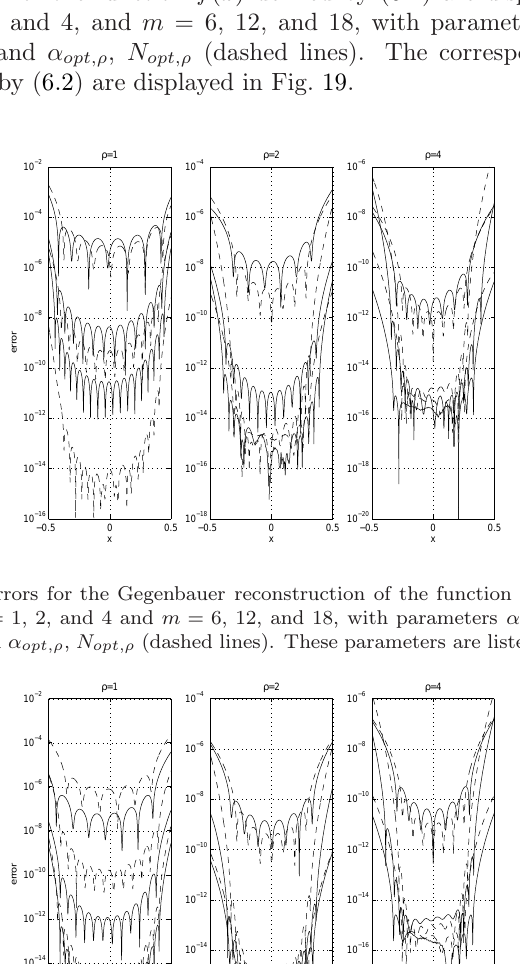
The corresponding values of N opt,ρ , N opt,I and N opt,R depend on m and are listed in Table 2 for m = 6 , 12 and 18 . The errors of the Gegenbauer reconstruction of the function f ( x ) defined by (6.1) are displayed in Fig. 18 for ρ = 1 , 2 , and 4 , and m = 6 , 12 , and 18 , with parameters α opt,I , N opt,I (solid lines) and α opt,ρ , N opt,ρ (dashed lines). The corresponding errors for f ( x ) defined by ( 6.2) are displayed in Fig. 19.